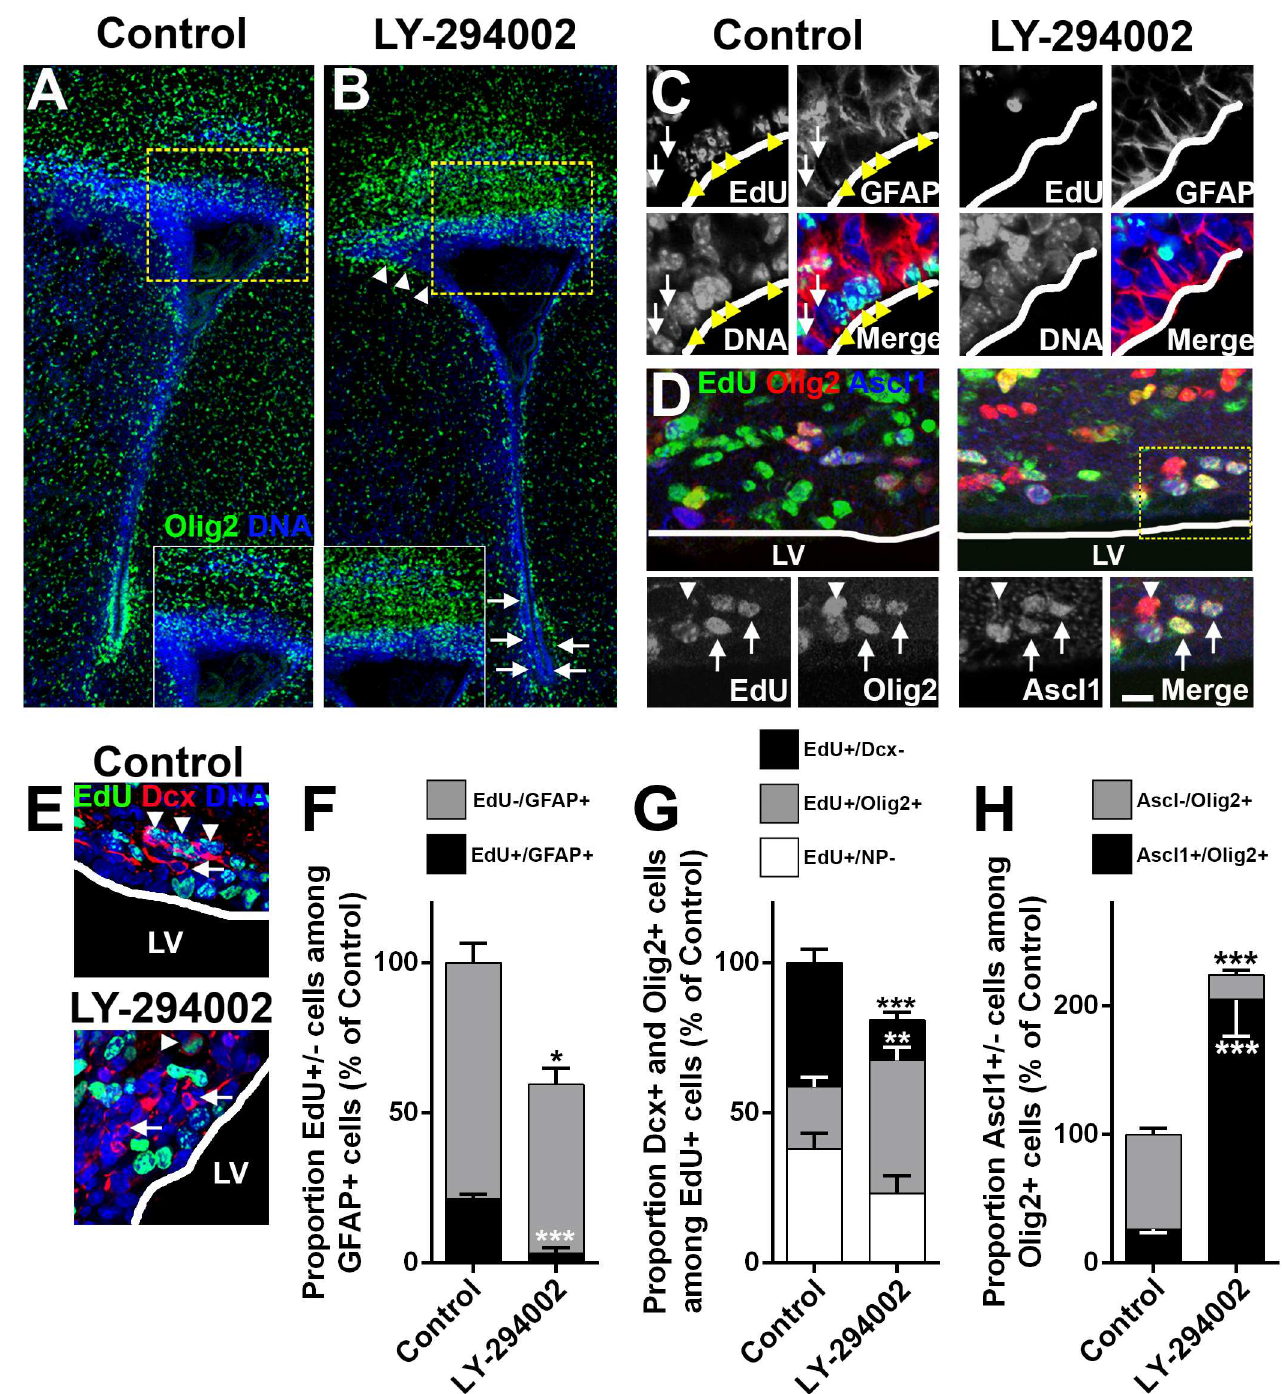
Fig 4. LY-294002promotes dorsal subventricular zone (dSVZ)-oligodendrogenesis. Pups were treated for 3 days with LY-294002or saline/ DMSO and examinedby immunolabeling. (A, B) Periventricular sections show greater Olig2 immunostaining in LY-294002in more dorsal periventricular regions comparedto controls, illustratedin expanded insets. In the lateral SVZ, LY-294002reducedOlig2 expression, as indicated by arrows (B) . Arrowheadsin (B) show reducednuclei density in the dorsolateral horn of the SVZ where neuronalprecursors (NPs) migrate. Scale bar in (A) = 200 μ m. (C) Arrowheadsshow a loss of EdU in GFAP+ cells directly facing the lateral wall in LY-294002comparedto controls. Arrows show examplesGFAP+ cells that have not incorporatedEdU that were increasedfollowingLY-294002. (D) Singleplane confocalmicrographs show greater EdU+\Olig2colocalization in LY-294002 and single panel captionsof single planesillustrate that most newly generatedOlig2+ cells co-express EdU and Ascl1 (arrows) or have absent or lower levels of Ascl1 (arrowheads). Scale bar in (D) = 10 μ m in captionsof (D) , 15 μ m in main